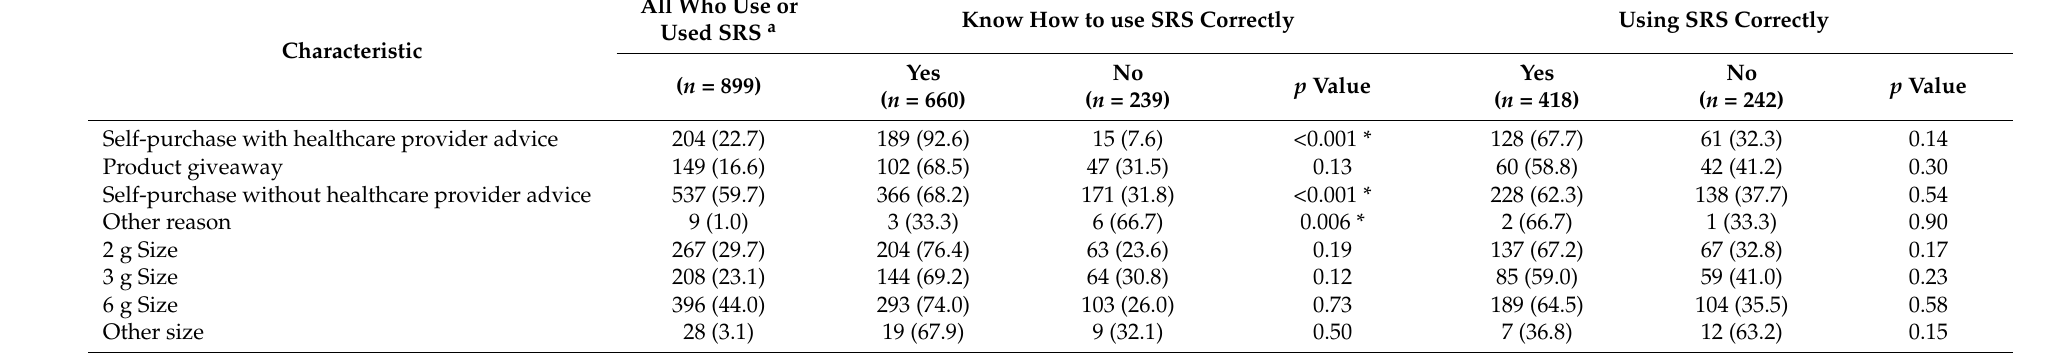
Table 2. Additional characteristics of the 899 salt-restriction spoon users, n